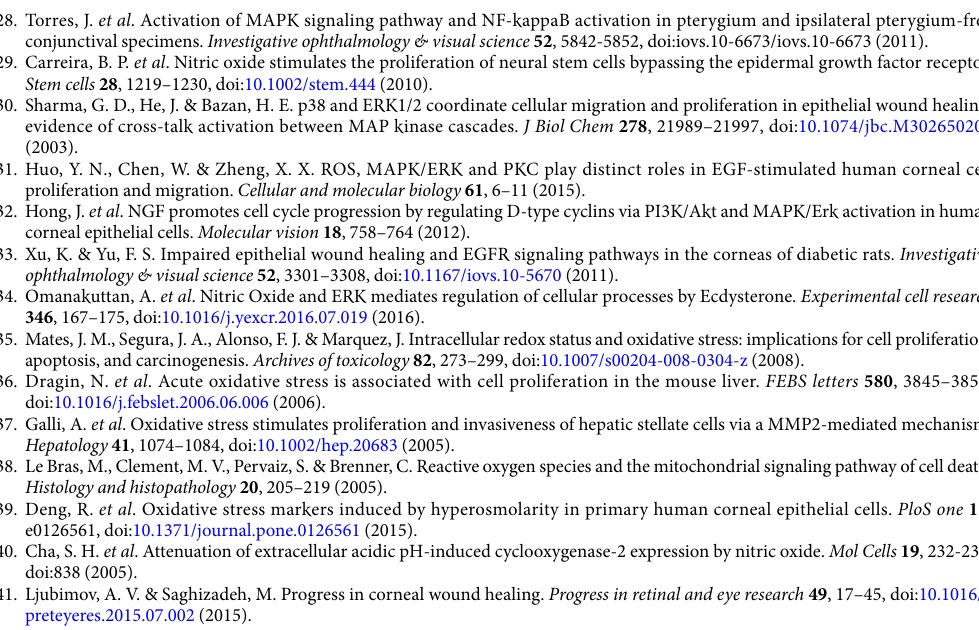
supplementary Figure 3 and D.J.K., J.Y.K. prepared Figure 7 and Table 1. R.S.C. and C.Y.P. corrected and proof read the manuscript. All authors reviewed the manuscript. Additional